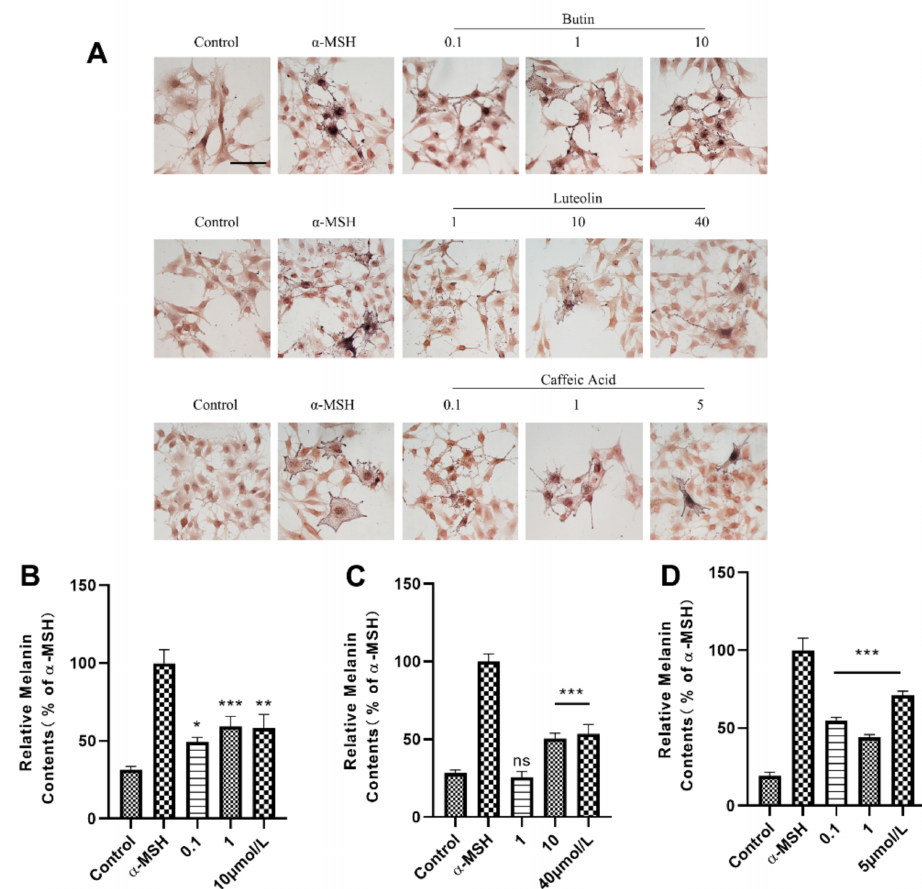
Figure 3. Compounds promote melanin synthesis on B16F10 cells. ( A ) Cells incubated with various concentration of butin [0.1, 1, 10] µ mol · L − 1 , luteolin [1, 10, 40] µ mol · L − 1 and caffeic acid [0.1, 1, 5] µ mol · L − 1 to test melanogenesis effect contrast to α -MSH (20 nM) group and control group. Cells were treated for 48 h. The scale bars represent 30 µ m. ( B – D ) are melanin contents (relative melanin contents % of α -MSH) in butin, luteolin and caffeic acid groups, results shown are mean ± SEM. Data were analyzed by ANOVA followed by post hoc Tukey test, ns, non-significant, * p < 0.05, ** p < 0.01, *** p < 0.001 vs. α